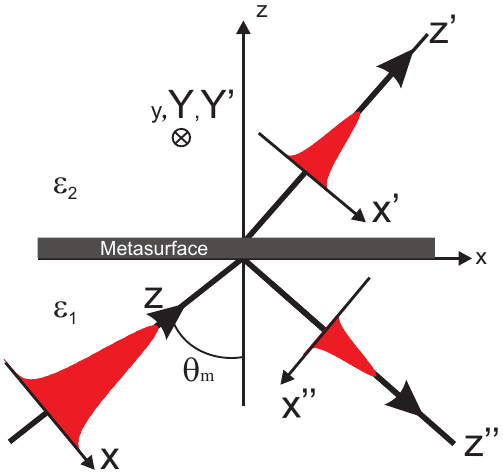
Figure 1. Schematic of the model with the different frames involved in the theoretical model: Oxyz the metasurface frame, OXYZ the incident beam frame, OX (cid:48)(cid:48) Y (cid:48)(cid:48) Z (cid:48)(cid:48) the reflected beam frame and OX (cid:48) Y (cid:48) Z (cid:48) the transmitted beam frame. θ m is the angle of